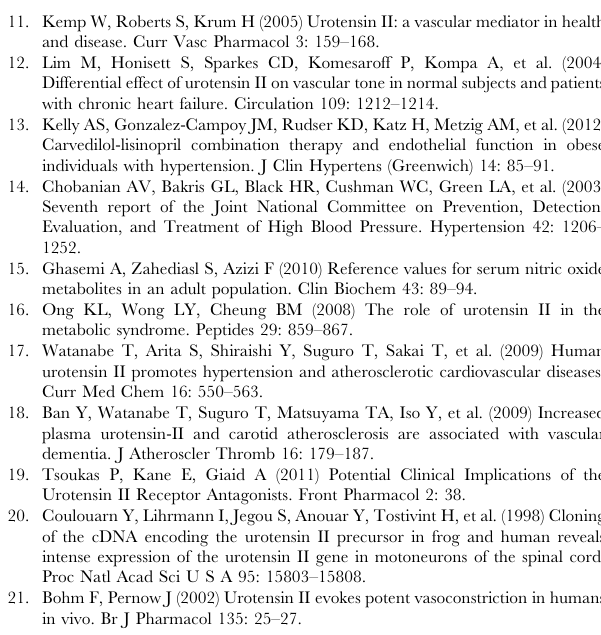
Figure S1 Selection of study